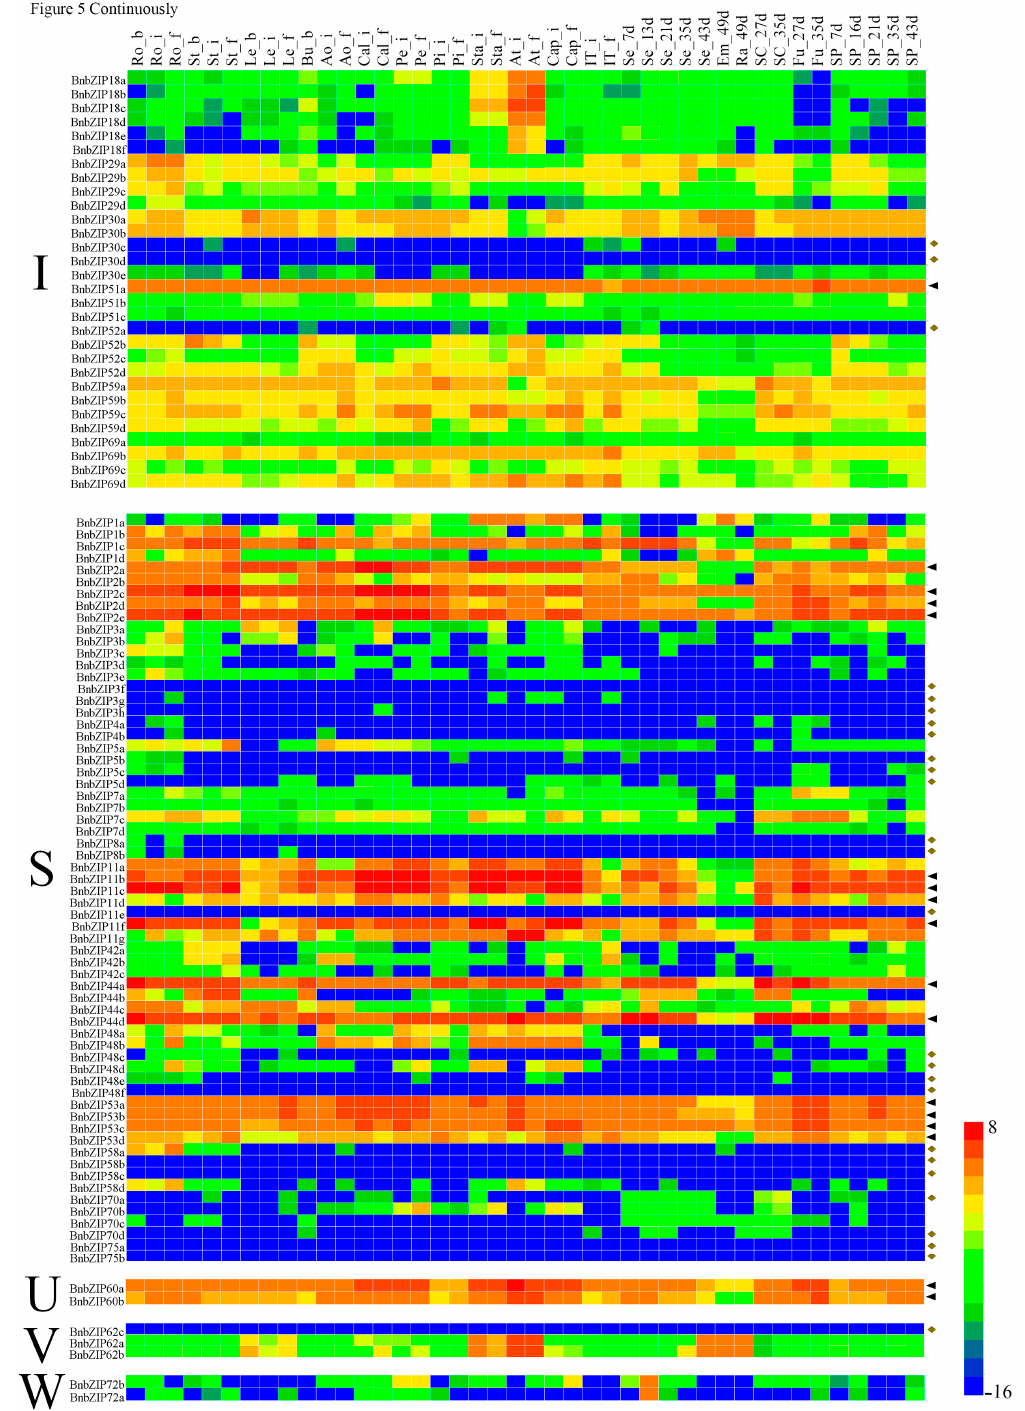
Figure 5. Heatmap of the expression levels of B . napus bZIP transcription factor family genes during different periods of development in different tissues and organs. Each subfamily is represented by a different uppercase letter (A–I, S, U–W). The black triangles correspond to higher expression levels in all tissues during the whole development, and the yellow diamonds correspond to lower expression levels in all tissues during the whole development. The abbreviations combinations above the heatmap indicate the different tissues and organs/developmental stages from B . napus ZS11 (listed in Table S3). The “scale” function in R was used to normalize relative expression levels ( R = log2/FPKM). The heatmap was generated using Heatmap Illustrator (HemI) [40].